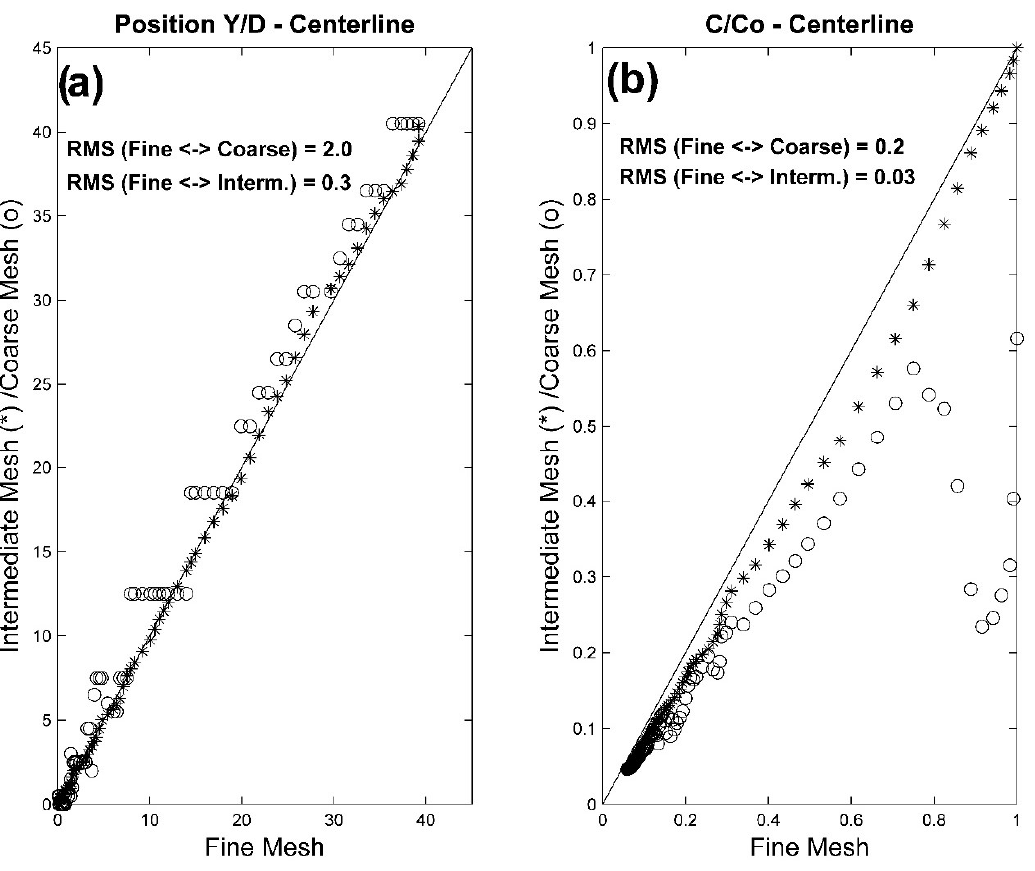
Figure 7. ( a ) Scatter plot of the centerline trajectory in dimensionless positions (X / D and Y / D), and ( b ) scatter plot of the C / C MAX along the centerline for the fine grid versus the medium grid (circle markers), and the fine grid versus the coarse grid (star markers). < - > indicates the used grids for the RMS calculation.